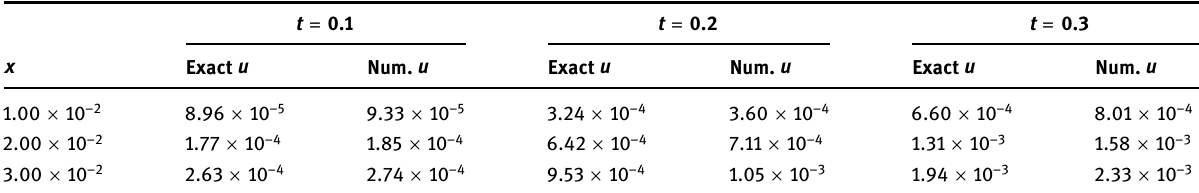
Table 7: Comparison of results at di ff erent node points and time levels regarding